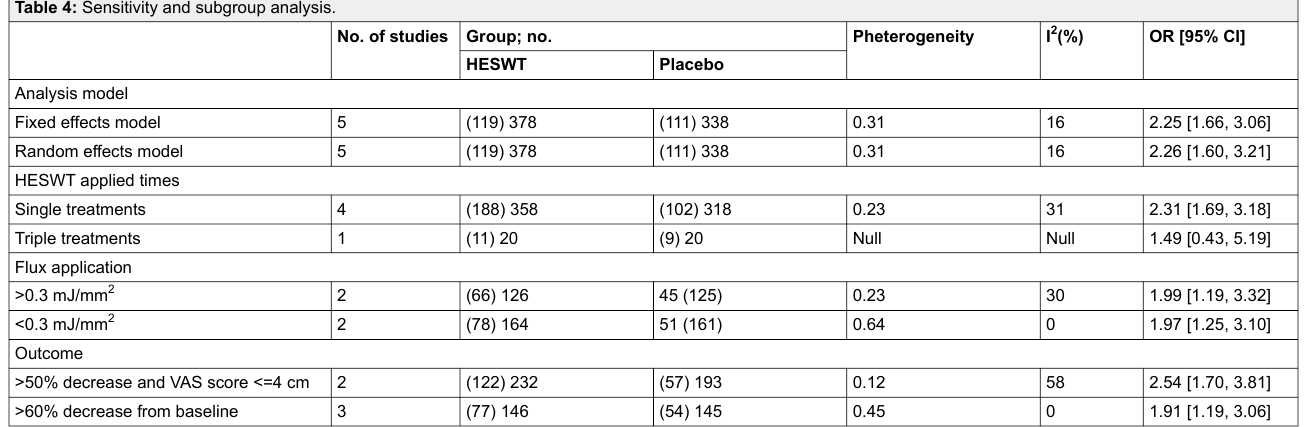
Table 4: Sensitivity and subgroup analysis.